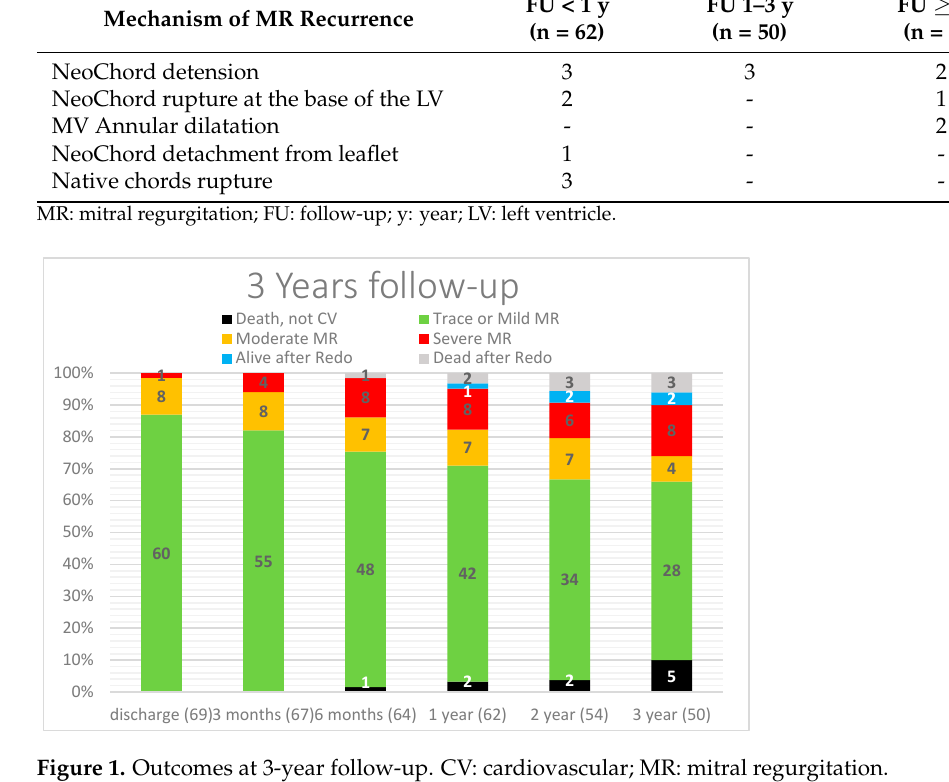
Table 4. Mechanisms of MR recurrence.